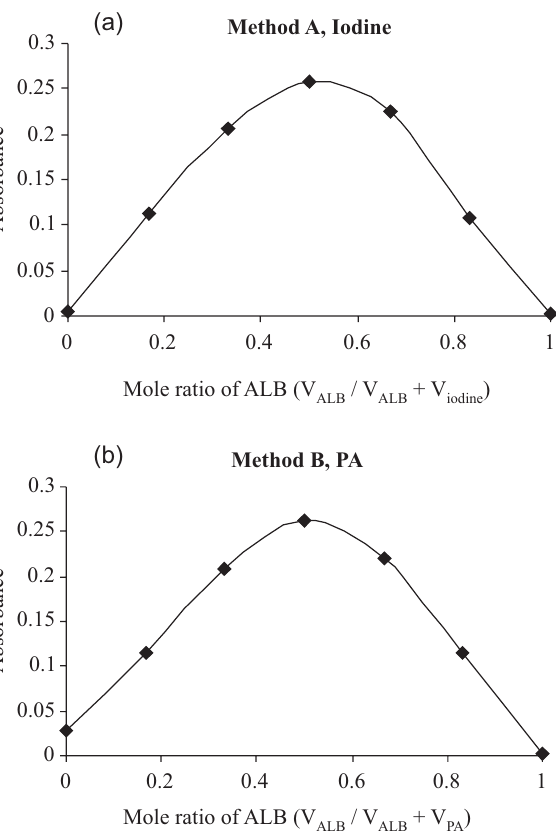
]=1.51×10 -3 M and 2